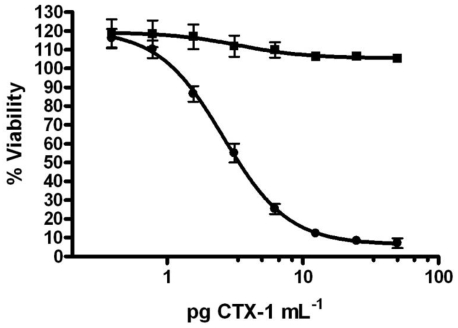
Neuroblastoma (Neuro-2a) cells exposed for 24 hours to P-CTX-1 in the presence or absence (▪) of ouabain (0.1 mM) and veratridine (0.01 mM). The proportion of O and V produced an approximate 20% cell mortality. No toxic effects of P-CTX-1 were measured when Neuro-2a cells were not treated with O and V (▪). P-CTX-1 is toxic to Neuro-2a cells in the presence of O and V (●) with 50% of cell mortality produced with a concentration of 3.3 pg CTX-1 (IC50 = 3.3 pg P-CTX-1 mL−1) [195].